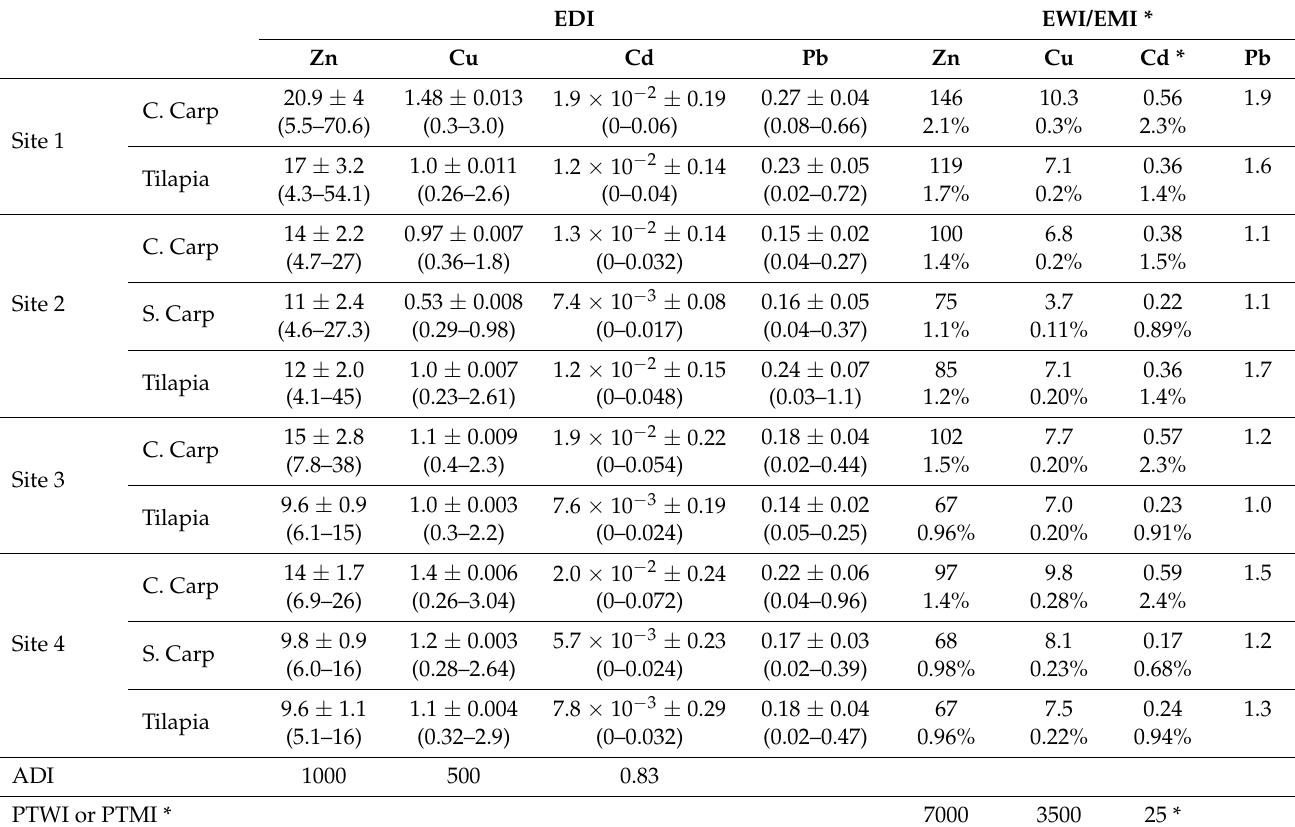
Table 5. Estimated daily intake (means ± SE) regarding the consumption of different metals in different fishes ( µ g/kg bw/day). Min and max EDI values are in the parentheses. Estimated weekly intakes (EWI; µ g/kg bw/week) for Zn, Cu and Estimated monthly intakes (EMI; µ g/kg bw/month) for Cd and acceptable daily intakes (ADI; µ g/kg bw/day). Provisional tolerable daily intake (PTWI, µ g/week/capita) and provisional tolerable monthly intake (PTMI, µ g/month/capita) were set by WHO/FAO [36], in which Zn: 7000, Cu: 3500 µ g/kg bw/week, Cd: 25 µ g/kg bw/month. Percentage of EWI or EMI in comparison with PTWI or PTMI were presented below each value. * indicates the estimated monthly intakes calculated for